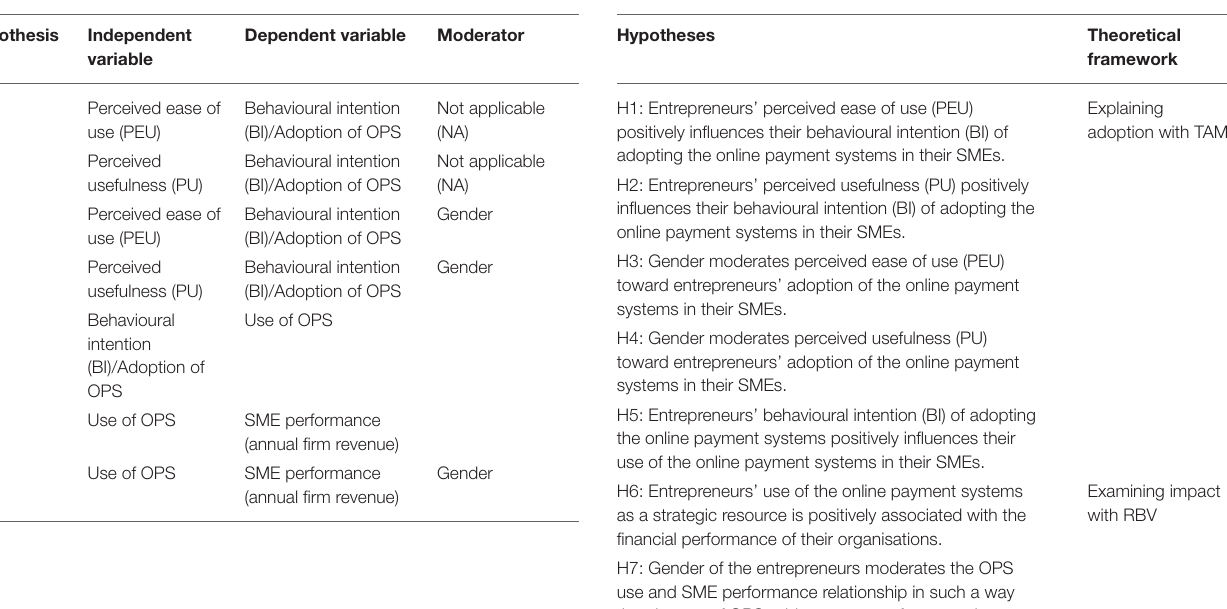
TABLE 2 | List of variables used in this research. TABLE 3 | Theoretical Framework related to